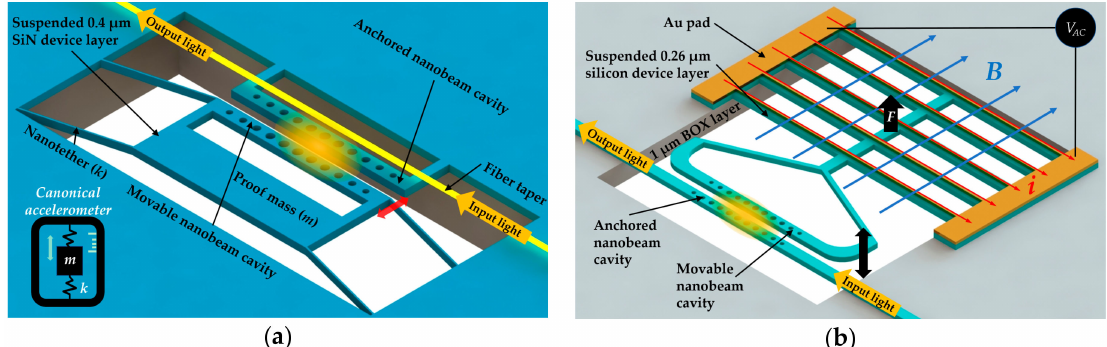
optomechanical accelerometer; ( b ) magnetic field